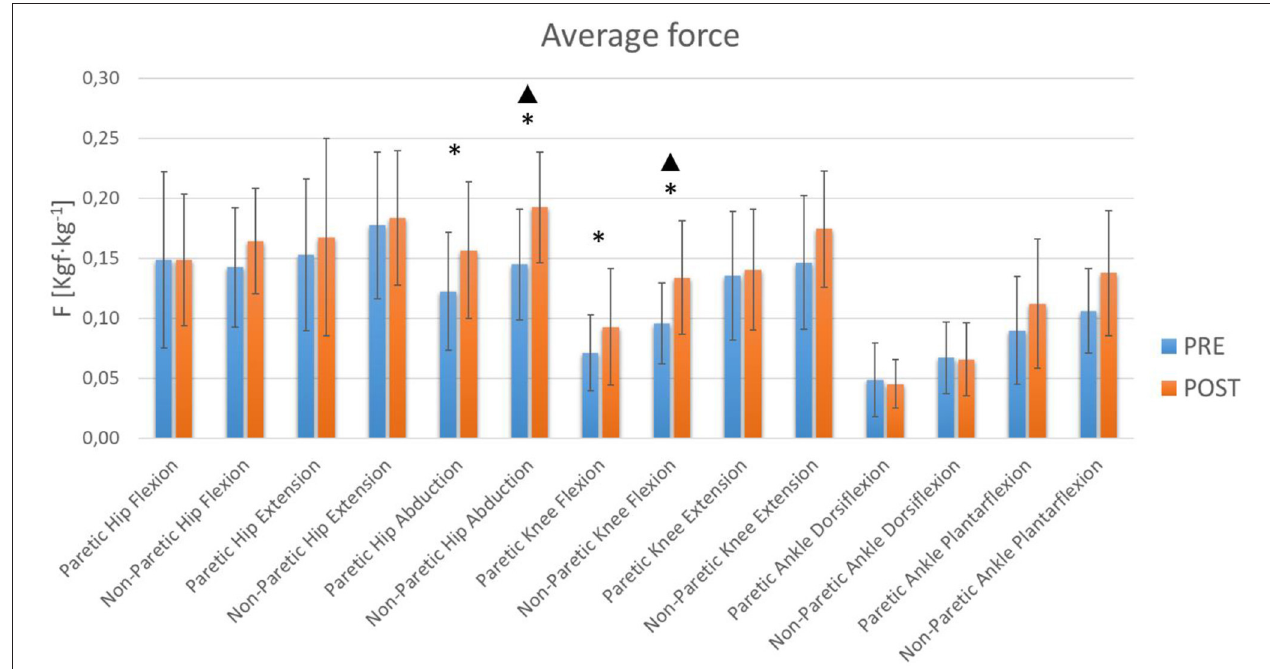
FIGURE 3 | Average Lower Limb Forces. The blue and orange bars show the mean value (M). The standard deviation (SD) is also shown through error bars. *Significant differences. N Statistical power > 80%.